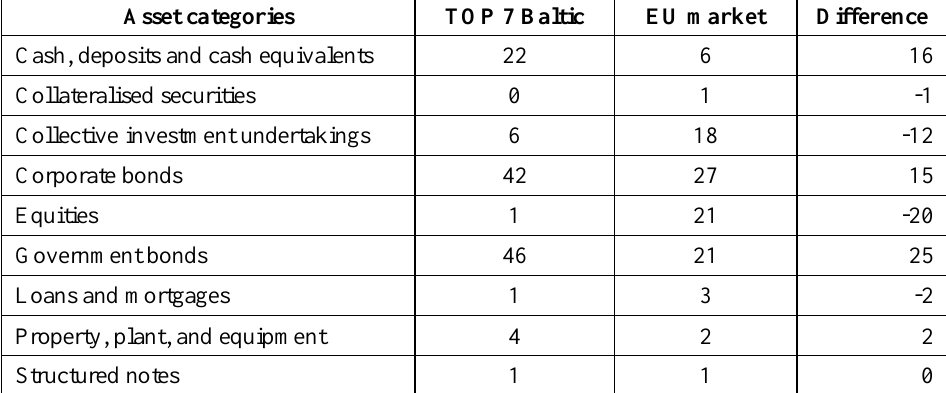
Table 3. Investment structure, percentages